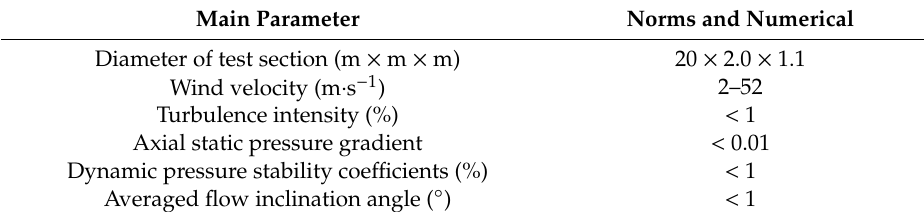
Table 1. Parameters of South China Agricultural University (SCAU) wind tunnel.